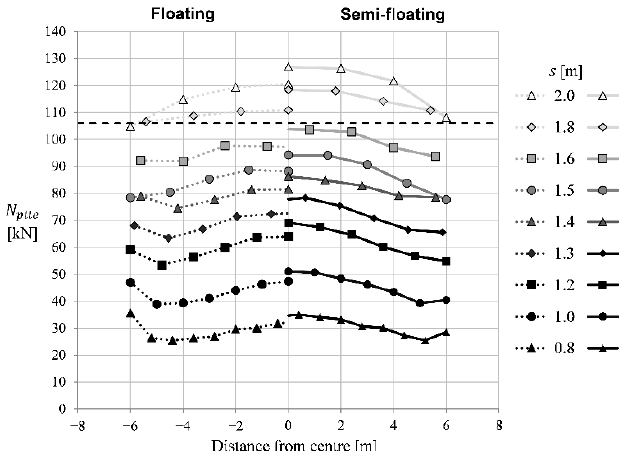
Figure 15. Axial pile load ( N pile ) across a pile row (as an average of the three pile rows modelled) in the modelled floating and semi-floating pile groups, showing the results of the left and right half of each respective pile group. The horizontal axis denotes the horizontal distance from the embankment longitudinal centre line. The structural pile capacity of 106 kN, European strength class C14 [49], is marked with a dashed horizontal line.